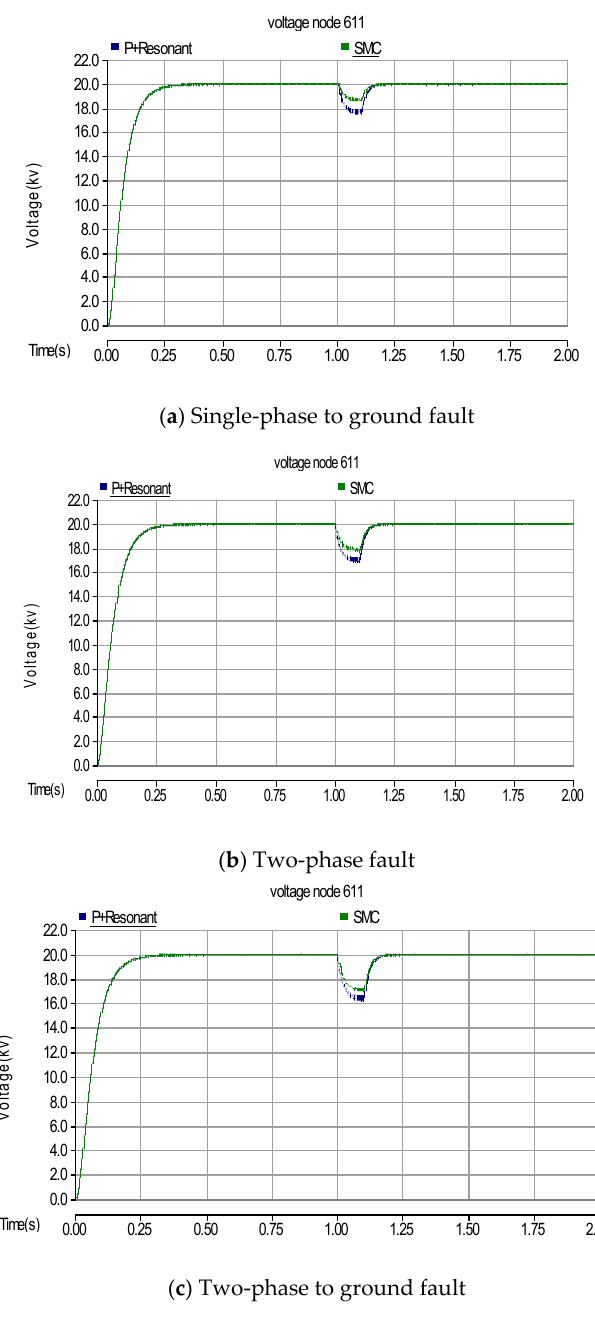
Figure 7. Voltage domain variations in bus 611 due to unsymmetrical short circuit faults in bus 671 and compensation with P+Resonant and SMC control systems.